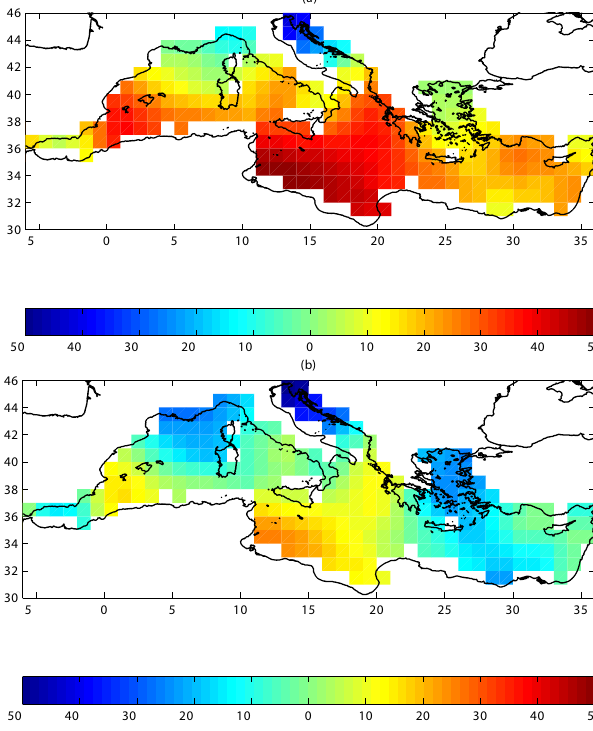
Fig. 5. Mean annual distribution of total heat flux at the sea surface FIGURE 4 corresponding (a) to Kondo-Bignami and (b) to Budyko-Kondo data set. Units are W/m 2 .